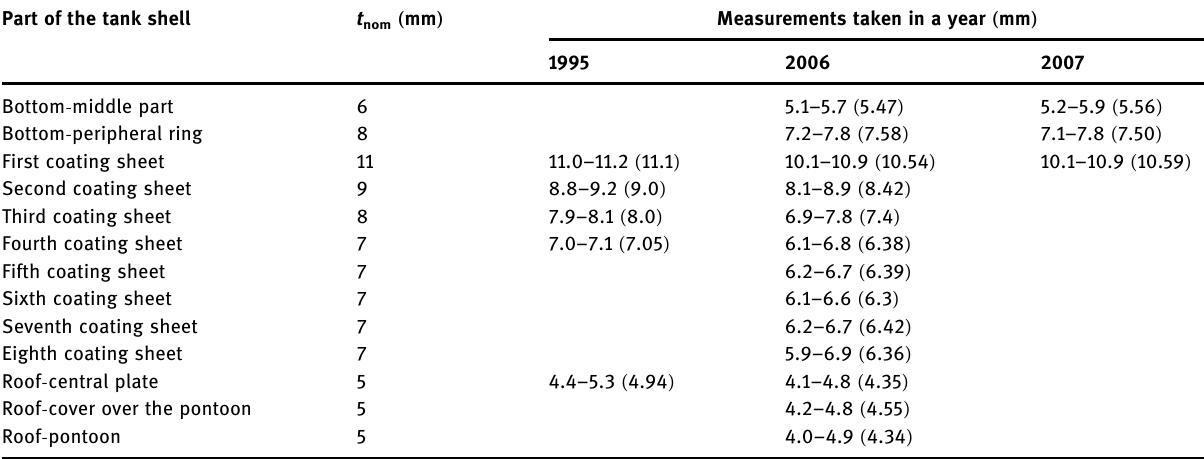
Table 1: Sheet thicknesses measured at di ff erent times in di ff erent locations of the tank number 1 steel shell Part of the tank shell